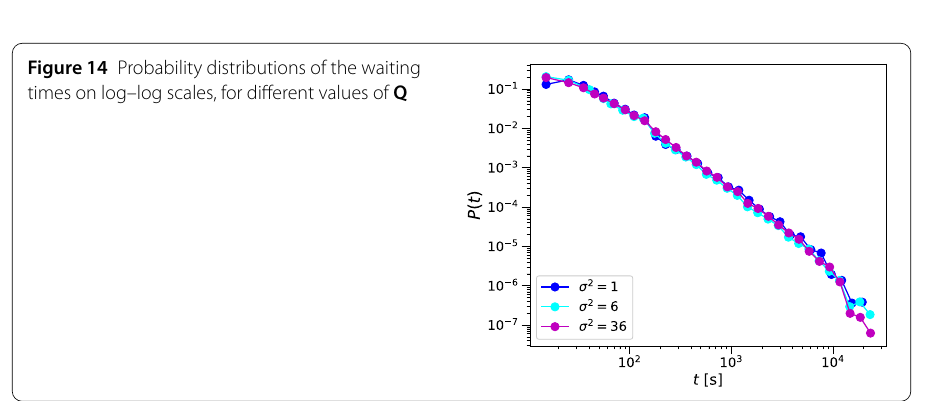
Figure 14 Probability distributions of the waiting times on log–log scales, for different values of Q